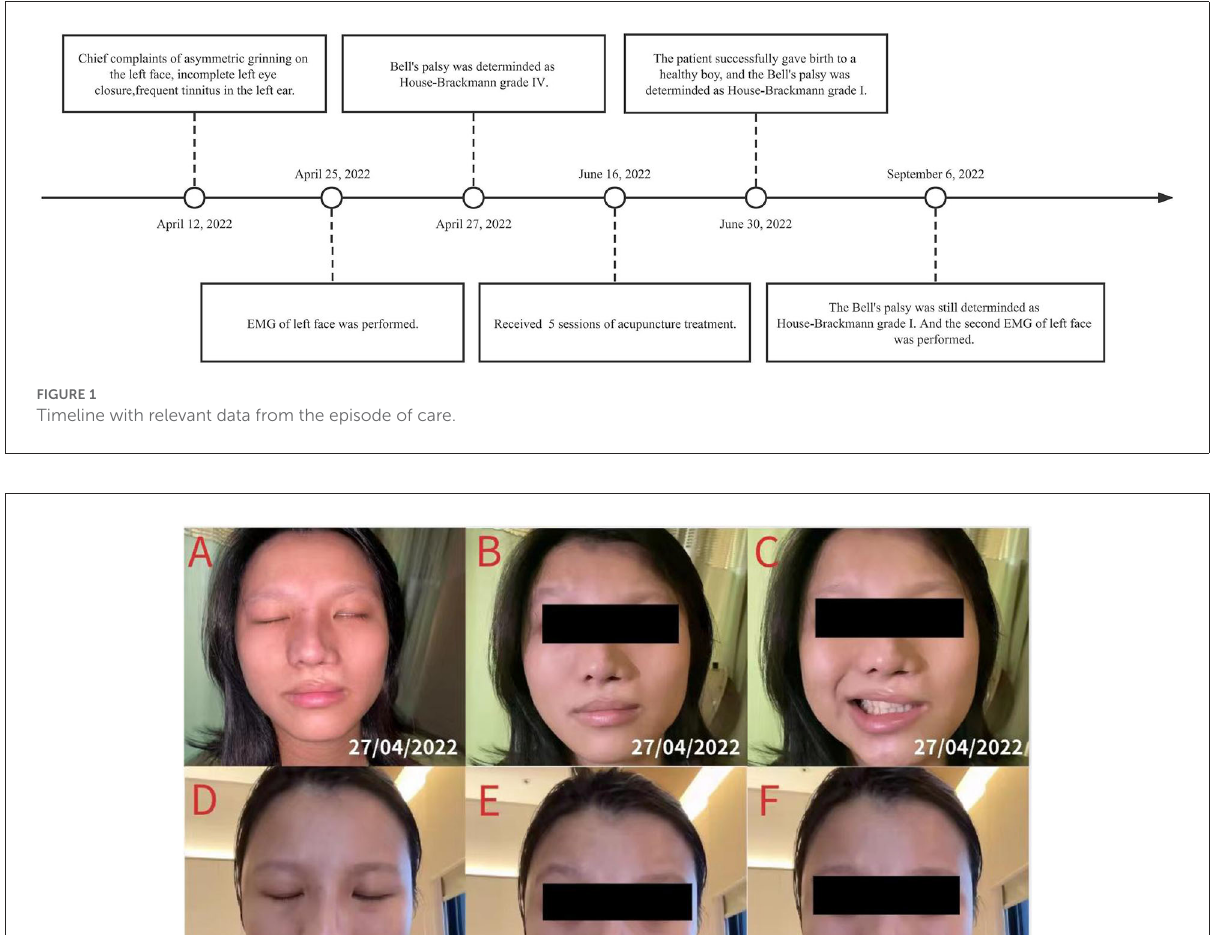
action potential (MNAP) of the left buccal branch of the facial nerve increased. The blink reflex showed that the latency of the left R1 was slightly longer than that of the right R1 (13.8